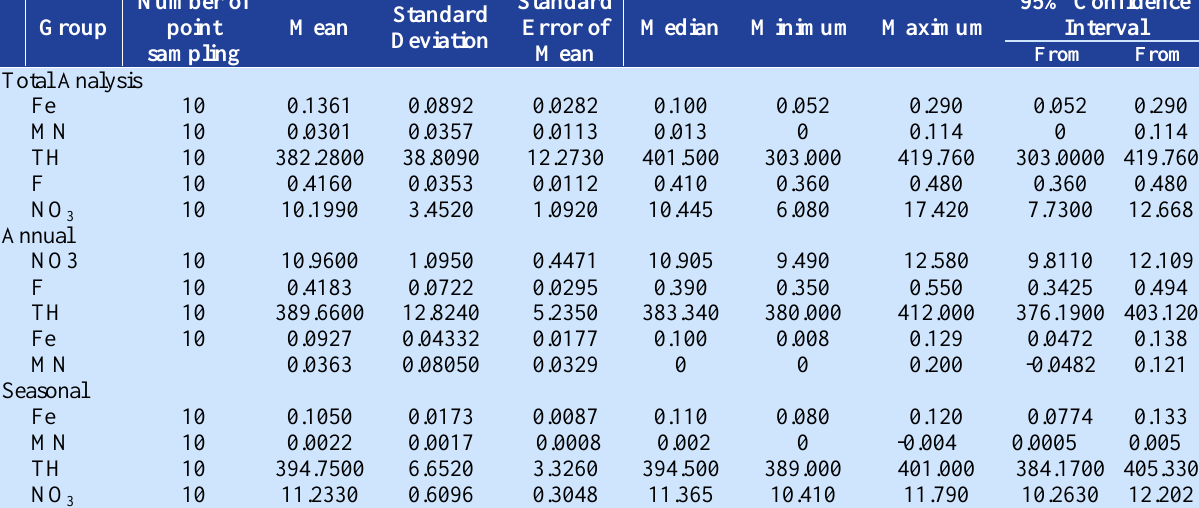
95% Confidence Interval From From